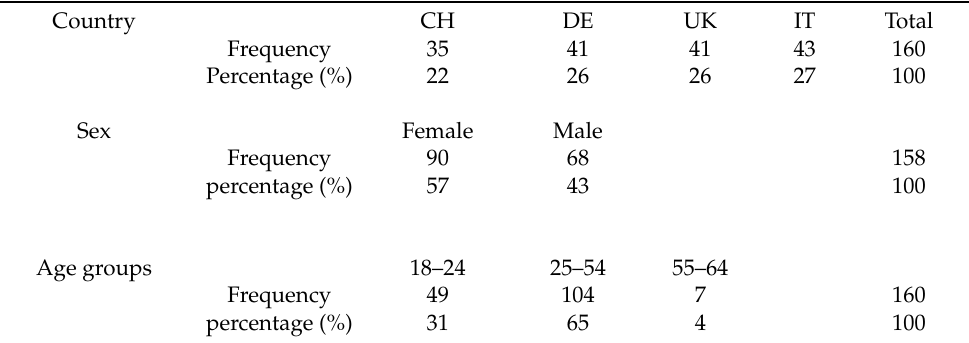
Table 1. Demographics by Country, Sex and Age